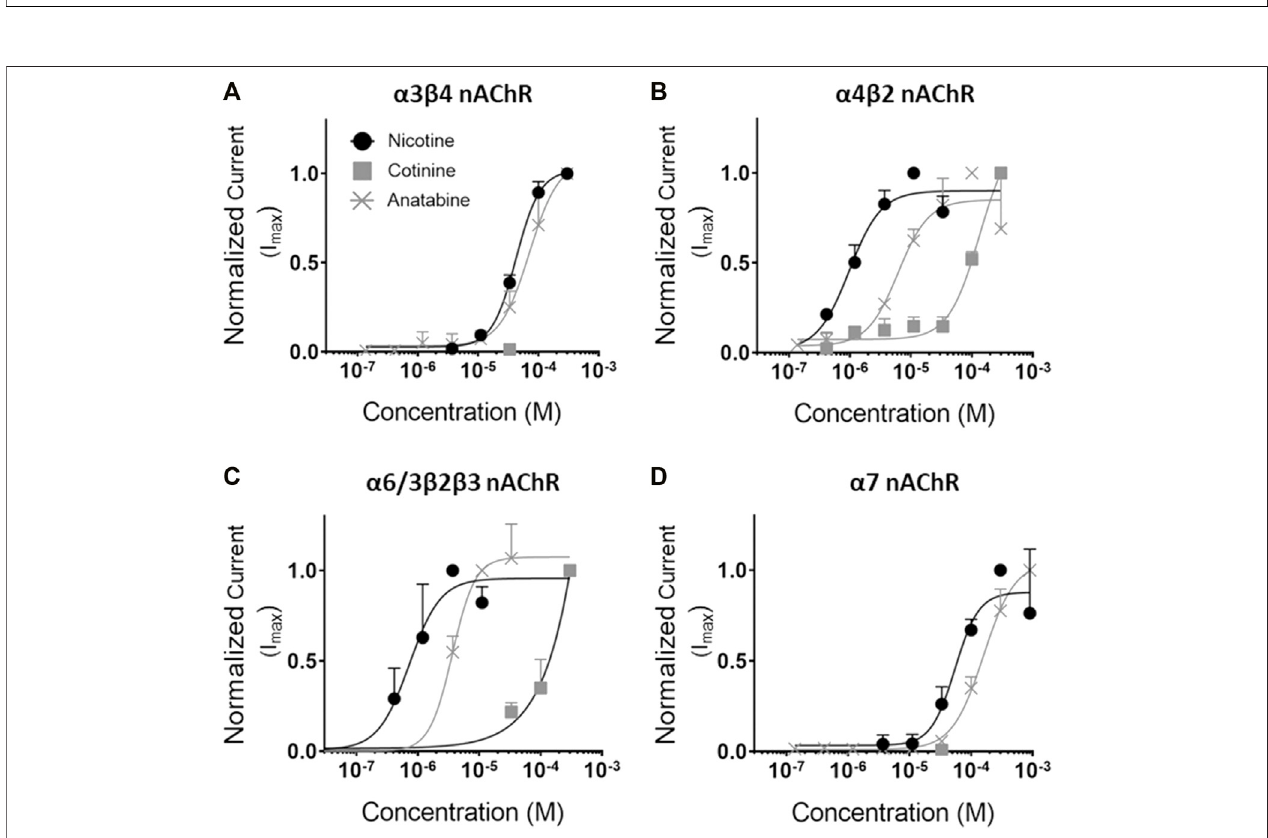
FIGURE 6 | Concentration response curves of the alkaloids for various nAChRs. Functional activity of nicotine, cotinine, and anatabine were tested against (A) α 3 β 4, (B) α 4 β 2, (C) α 6/3 β 2 β 3, and (D) α 7 in vitro . Mean EC 50 values (in µM) are indicated in Table 1 . Nicotine = black lines with solid circles; Cotinine = grey lines with solid squares; anatabine = grey lines with crosses. Data are presented as mean ± S.D.